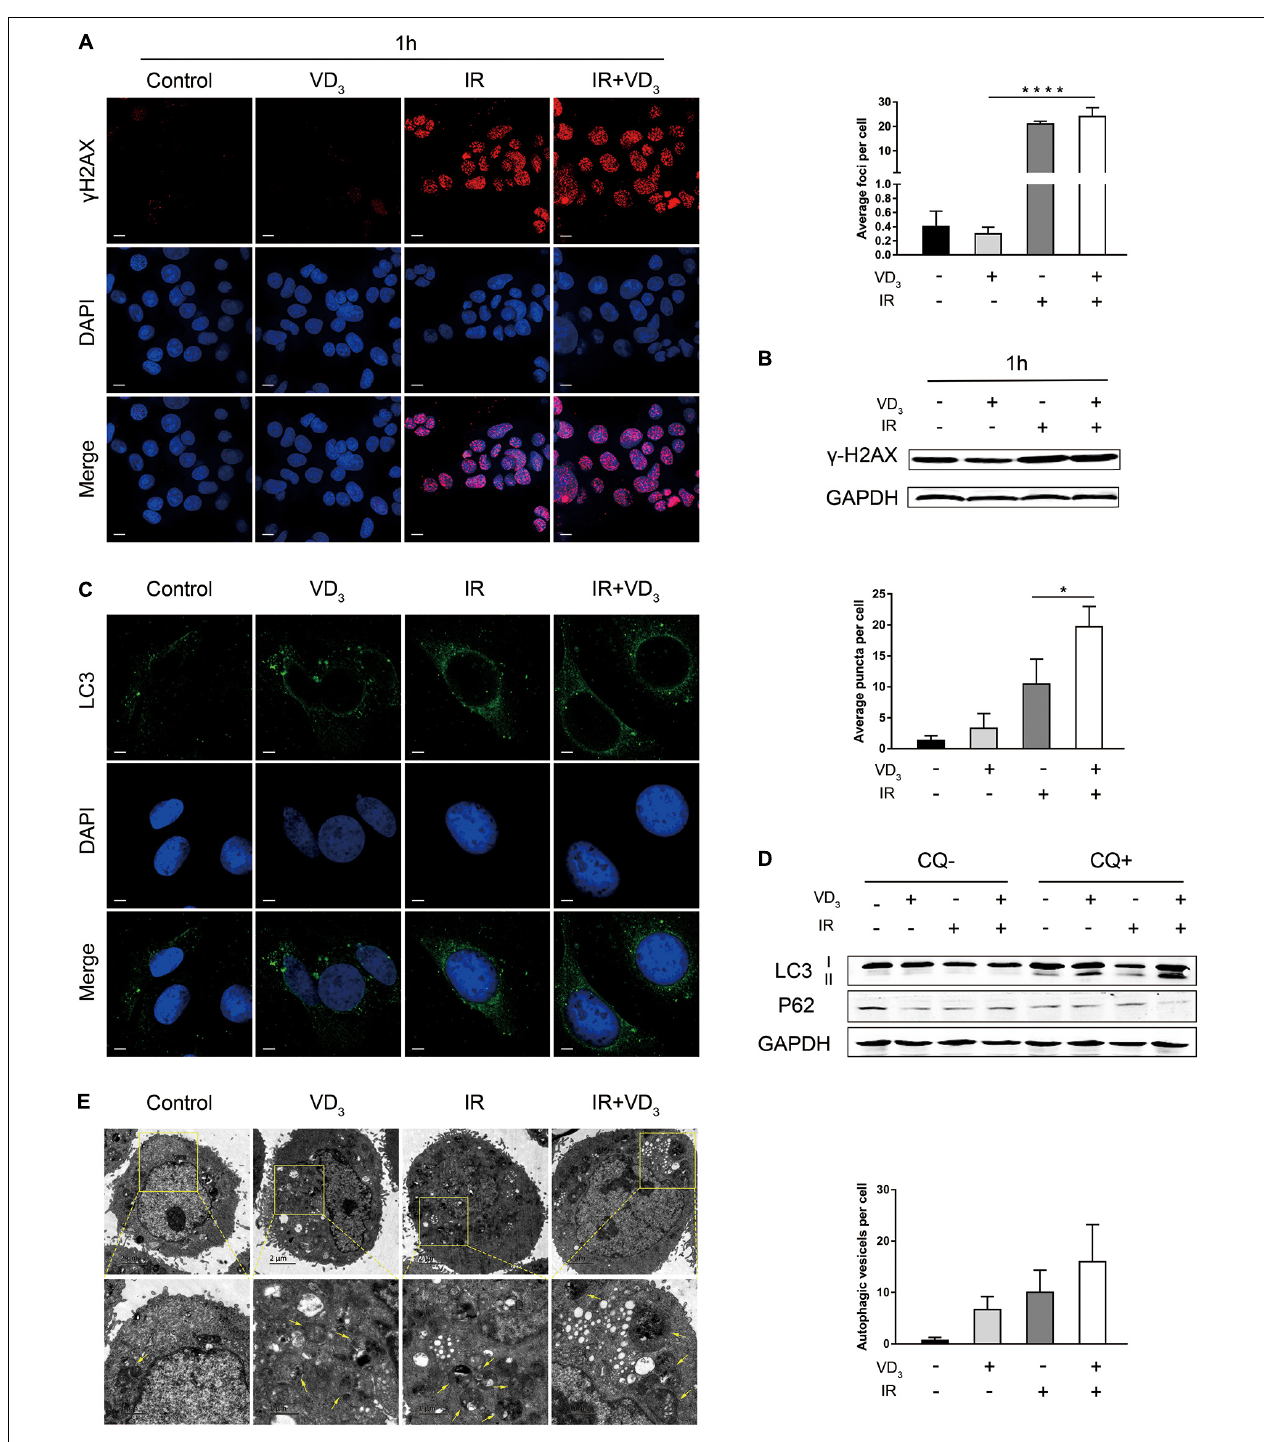
FIGURE 2 | VD 3 combined with IR participated in DNA damage and autophagy. (A) SW480 cells were treated with Control, VD 3 , IR, and IR plus VD 3 treatment for 1 h post IR. Immunofluorescence staining for γ -H2AX foci formation (DNA damage marker). Scale bar: 20 µ m. (B) γ -H2AX expression was detected by western blot. (C) Representative confocal fluorescence of LC3B puncta (autophagy marker) after the indicated treatments. Scale bar: 20 µ m. (D) LC3B expression was analyzed by western blot. (E) Representative transmission electron microscope (TEM) images with indicated treatments in SW480 cells. Scale bar: 1 µ m. Yellow arrowheads denote autophagic vesicles. Autophagic vesicles per cell were quantified. *p < 0.05, ****p < 0.0001.